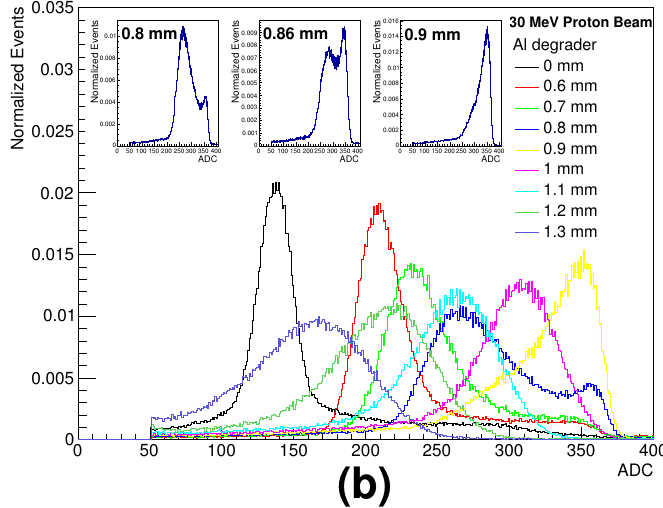
Figure 11. Pulse Height Distributions of Silicon Detector for Different Proton Energies Obtained with Aluminum Degraders: ( a ) 45 MeV and ( b ) 30 MeV Proton Beam Energies.